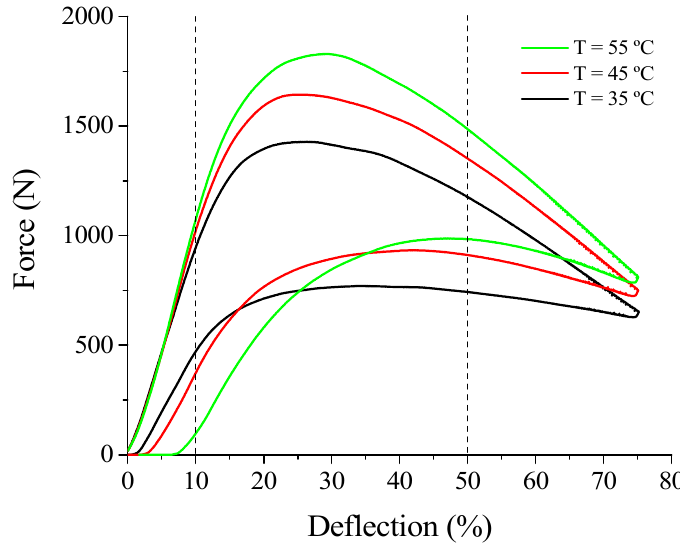
Figure 5. Isothermal superelastic response at low frequency (0.1 Hz) of the NiTi Belleville spring observed in force vs. deflection curves. The vertical lines indicate the deflection range selected for the cyclic compression tests.